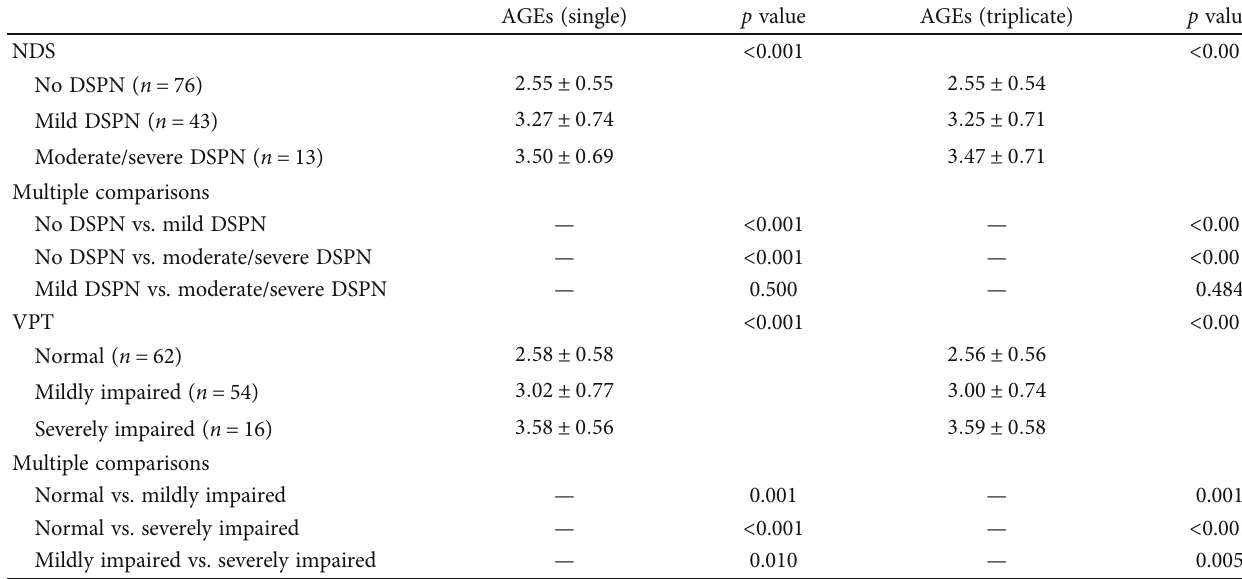
Table 2: AGEs in relation to the severity of